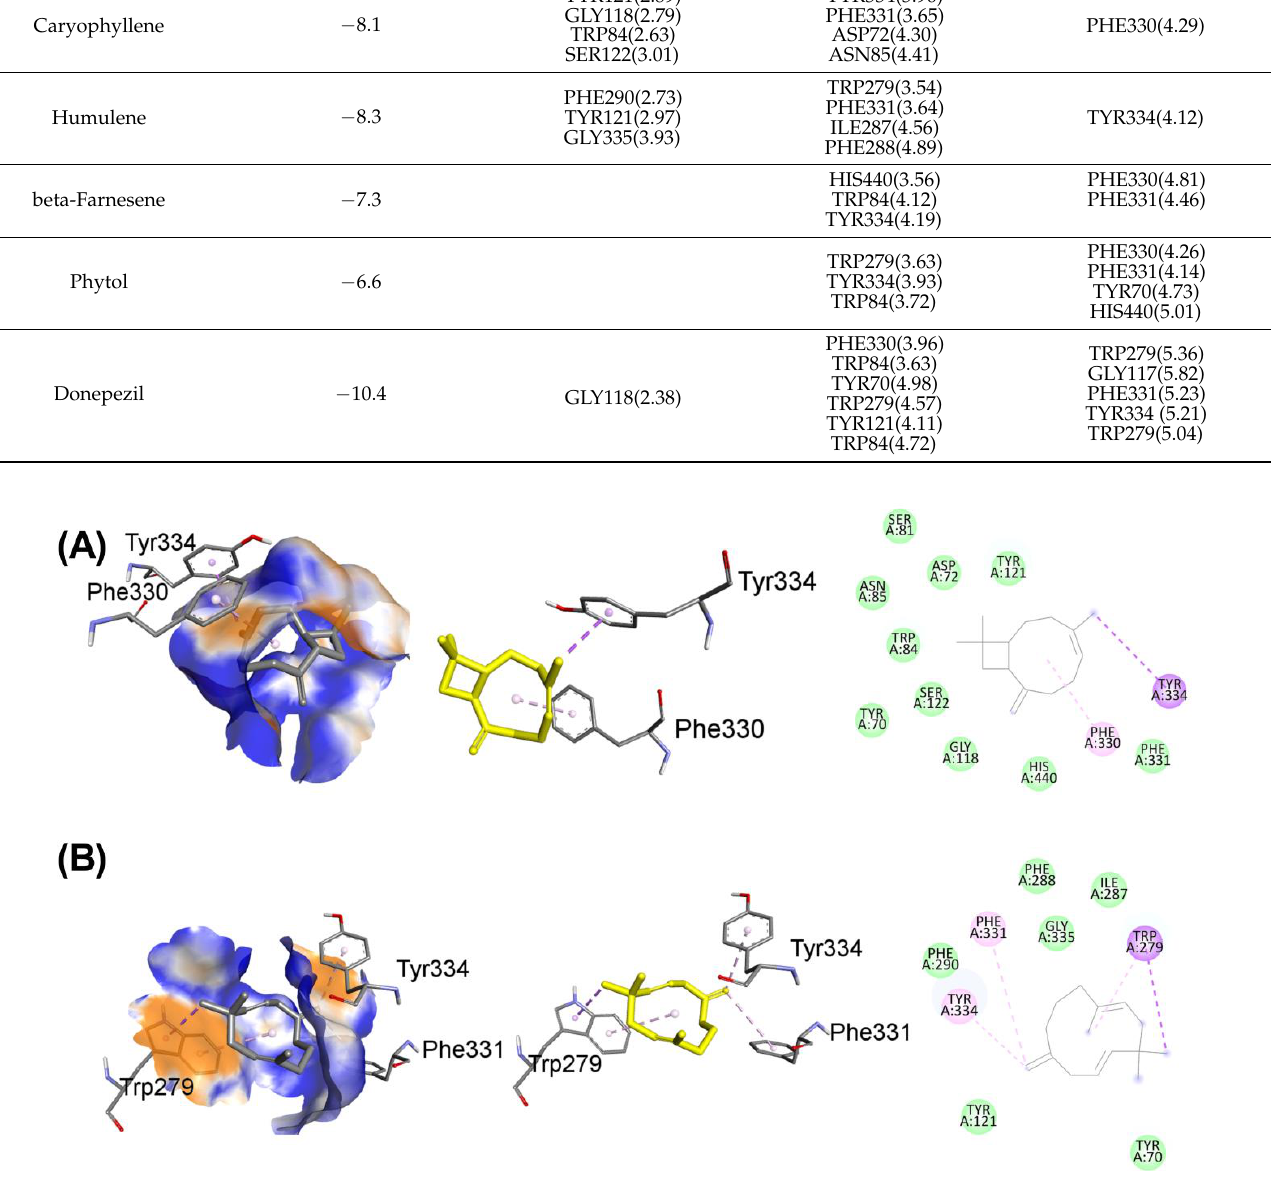
Figure 12. The binding mode with hydrogen acceptance (blue) and hydrogen donor (orange color) surface (leftmost), with 3D interaction having drug in yellow color (middle) and with 2D binding interactions (rightmost) ( A ) caryophyllene and ( B ) humulene using target acetylcholinesterase pro- tein 1GQR. Green colors are indicating hydrogen bonding and weak hydrogen bond interactions, whereas the dark purple color indicates hydrophobic interactions and light purple shows the electrostatic binding linkages.